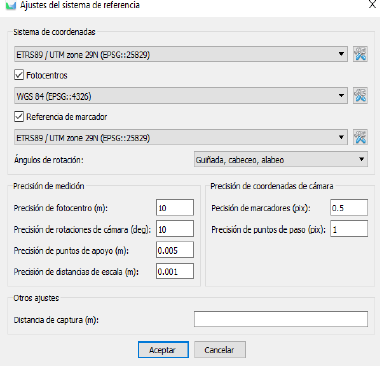
Figure 6. Reference System Adjustment Parameters.